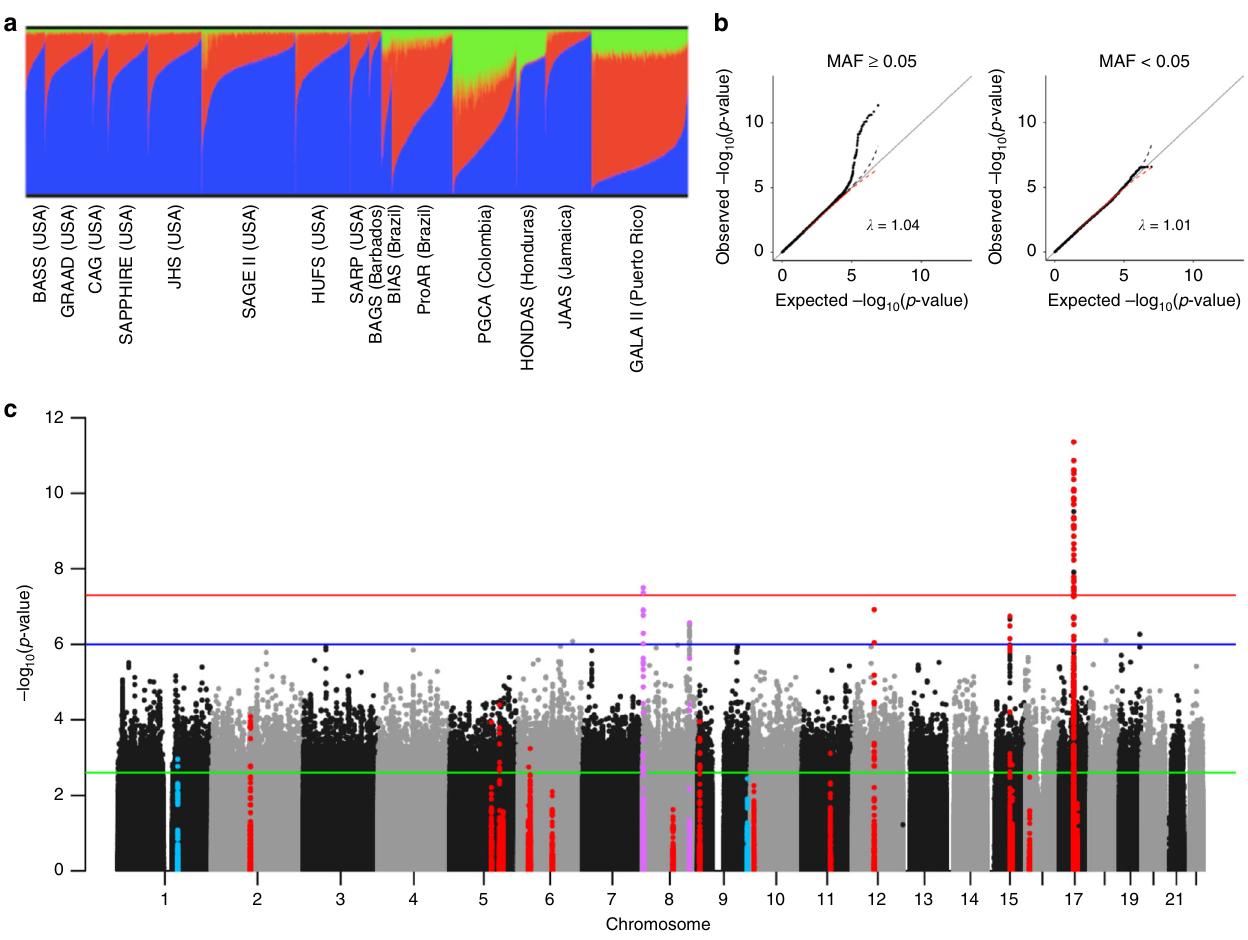
Fig. 1 Summary of CAAPA ancestry and meta-analysis results. a CAAPA ADMIXTURE estimates: this panel summarizes the genome-wide proportions of ancestry for K = 3 populations, as estimated by the software program ADMIXTURE. A combined dataset of 20,482 overlapping and linkage disequilibrium pruned SNPs in 84 African (YRI, blue) and 84 European (CEU, red) 1000 Genomes Project phase 3 subjects, 43 Native American (green) subjects and 12,223 putatively unrelated CAAPA subjects were used to estimate these ancestry proportions. b QQ plot of the meta-analysis p -values: the plots in this panel are strati fi ed by minor allele frequency (MAF) for low frequency and common SNPs. In fl ation factors were calculated by transforming MR-MEGA association p -values to 1 degree of freedom (df) Chi-square statistics, and dividing the median of these statistics by the median of the theoretical Chi- square (1 df) distribution. The dashed black and red lines represent the upper and lower 95% con fi dence interval. c Manhattan plot of the meta-analysis p -values: the red, blue, and green horizontal lines in the Manhattan plot represent signi fi cant (MR-MEGA association p < 5 × 10 − 8 ), suggestive (MR-MEGA association p < 10 − 6 ), and candidate gene (MR-MEGA association p < 2.6 × 10 − 3 ) value thresholds, respectively. The candidate gene threshold is a Bonferroni-adjusted alpha level for 20 tests (1 locus from EVE, 1 locus from eMERGE, and 18 loci from TAGC). Windows of ±10 KB around the lead SNP at each selected locus are colored blue (EVE and eMERGE loci), red (TAGC loci), and purple (CAAPA loci with lead SNPs having p < 10 − 6 ). A larger window of ±200 KB is shown for the chromosome 17q12 – 21